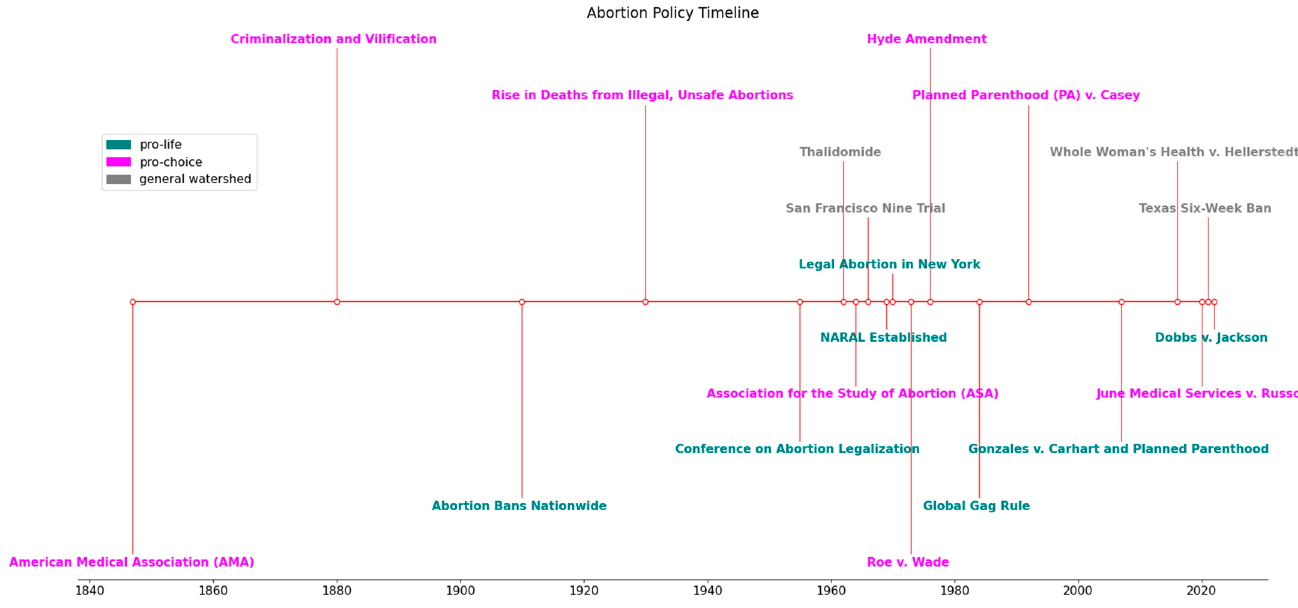
Figure A1. Abortion Policy Timeline.